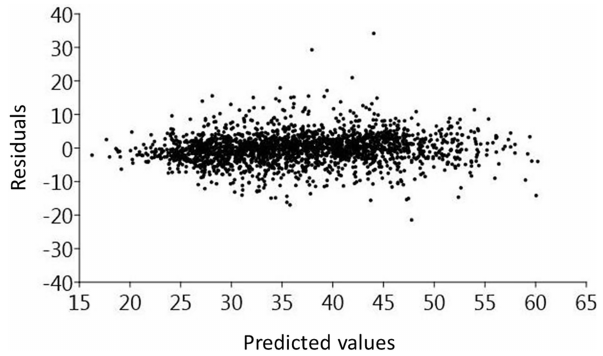
Figure B2. Scatterplot between residuals and predicted values.